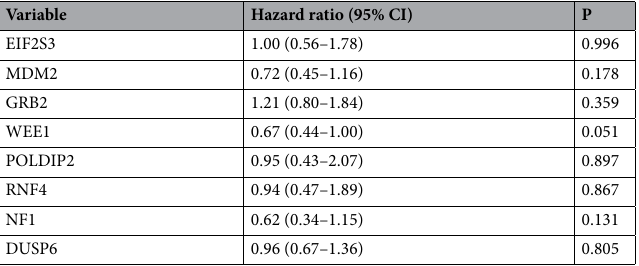
Table 5 . Bivariate analysis based on the Cox model. $ Controlling for sex and age.